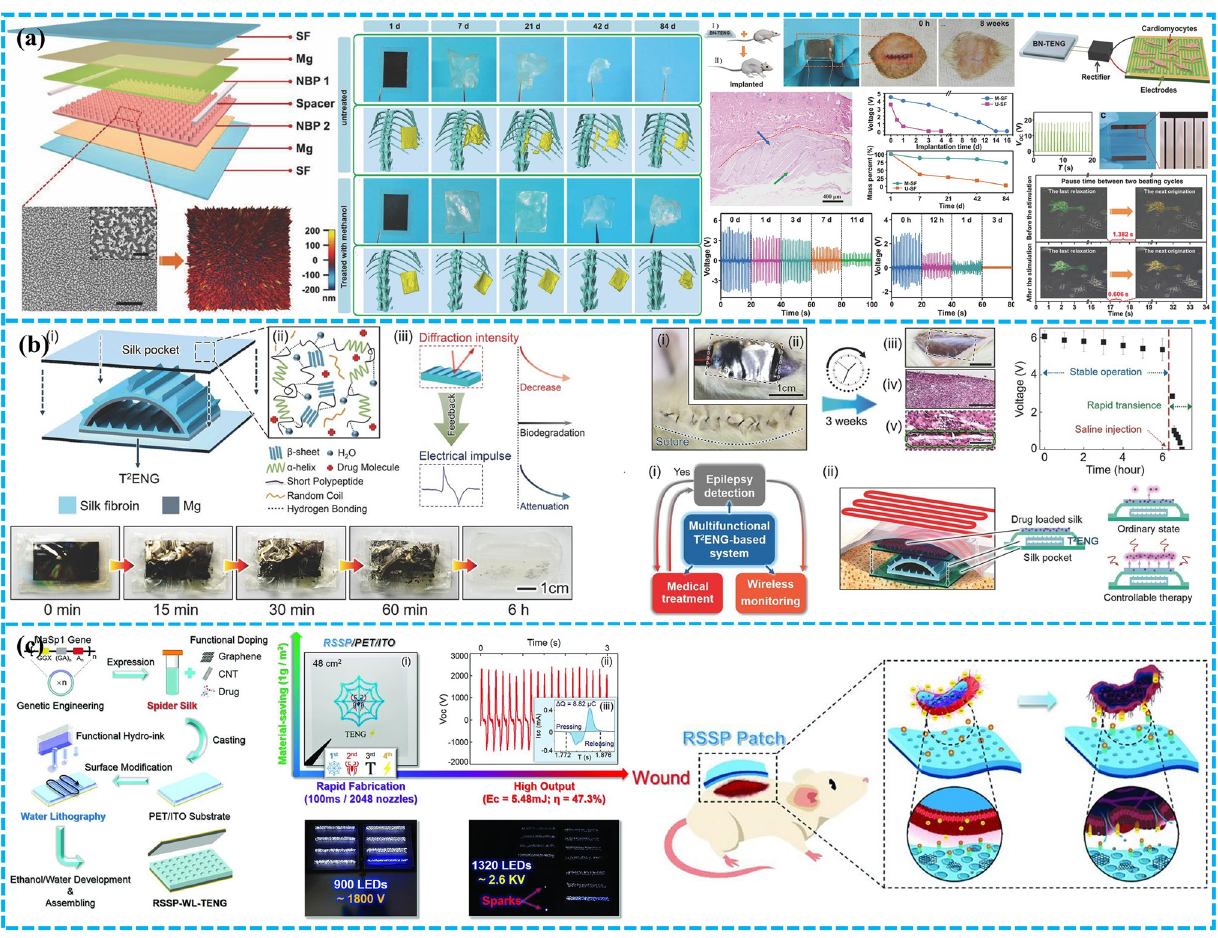
Figure 11. TENG based on animal extracts for implantable medical devices. ( a ) A full BD-TENG based on natural materials. Reproduced with permission [37], Copyright 2021, WILEY-VCH. ( b ) An implantable, biodegradable, and multifunctional system based on silk, self-powered by transient TENG (T 2 ENGs). Reproduced with permission [39], Copyright 2018, WILEY-VCH. ( c ) A biocompat- ible TENG with programmable triboelectric properties, multi-function, large-scale manufacturing capability, and excellent output performance through genetically engineered RSSP. Reproduced with permission [115], Copyright 2018, WILEY-VCH.